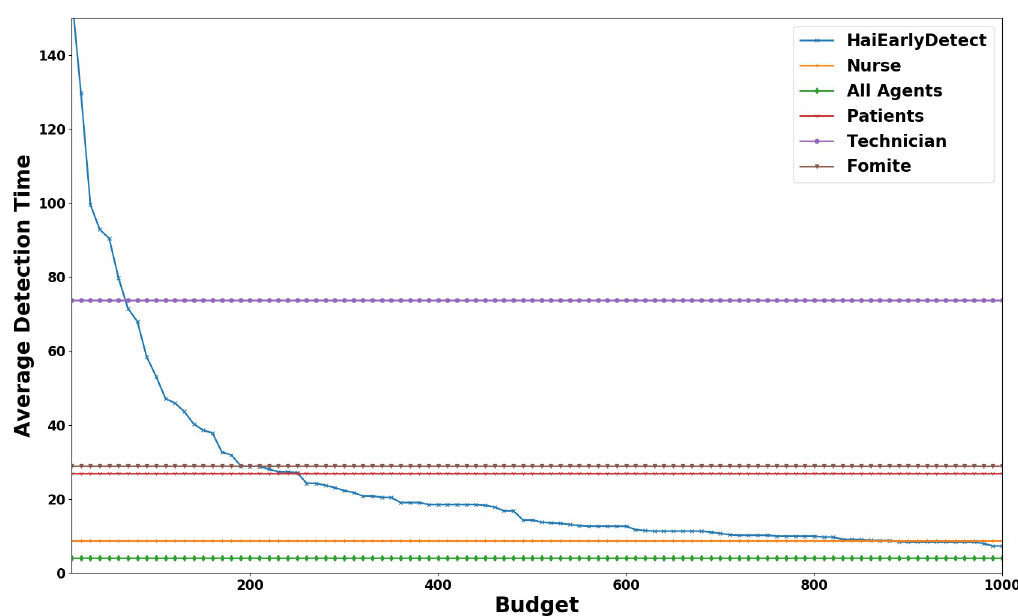
Fig 9. Average dectection time (in days) for various budgets. The flat lines are the detection time for monitoring all members of different categories of agents. Note that for a budget of 1000, monitoring sensors selected by H AI E ARLY D ETECT detect future outbreaks earlier than monitoring all nurses.